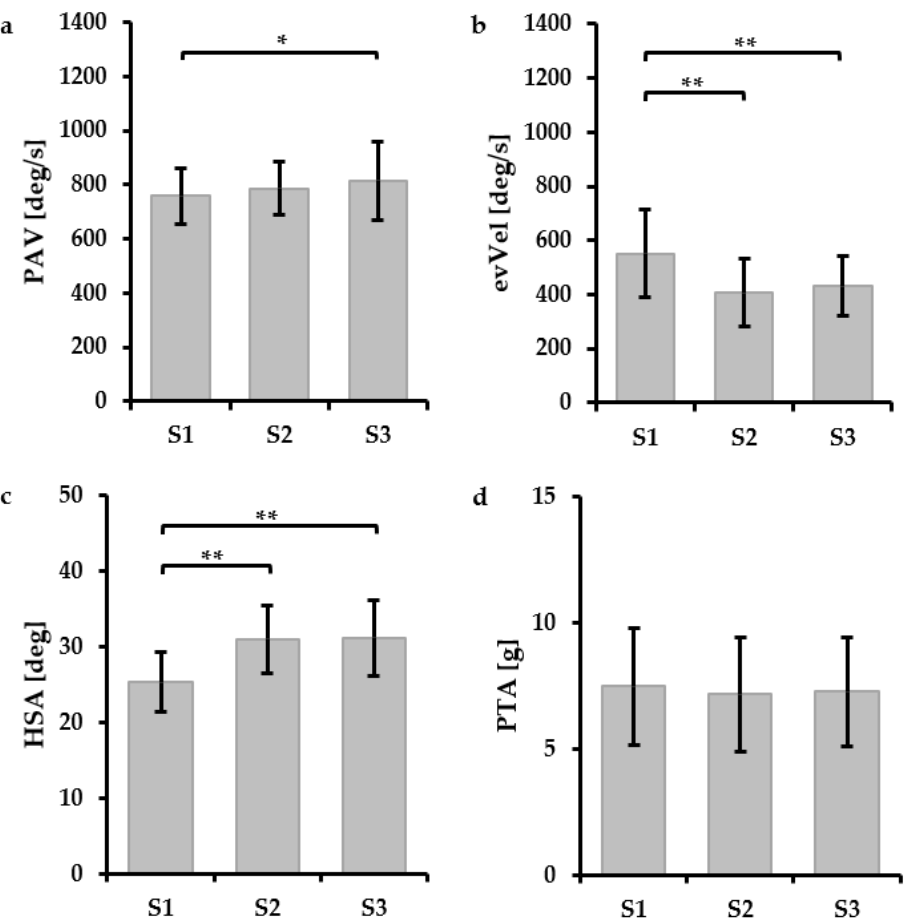
Figure 3. Comparison of shoe conditions for: ( a ) peak angular velocity (PAV); ( b ) maximum eversion velocity; ( c ) heal strike angle and (HSA); and ( d ) peak tibial acceleration (PTA). Significant differences between shoe conditions are marked with * ( p < 0.05) and ** ( p < 0.001).